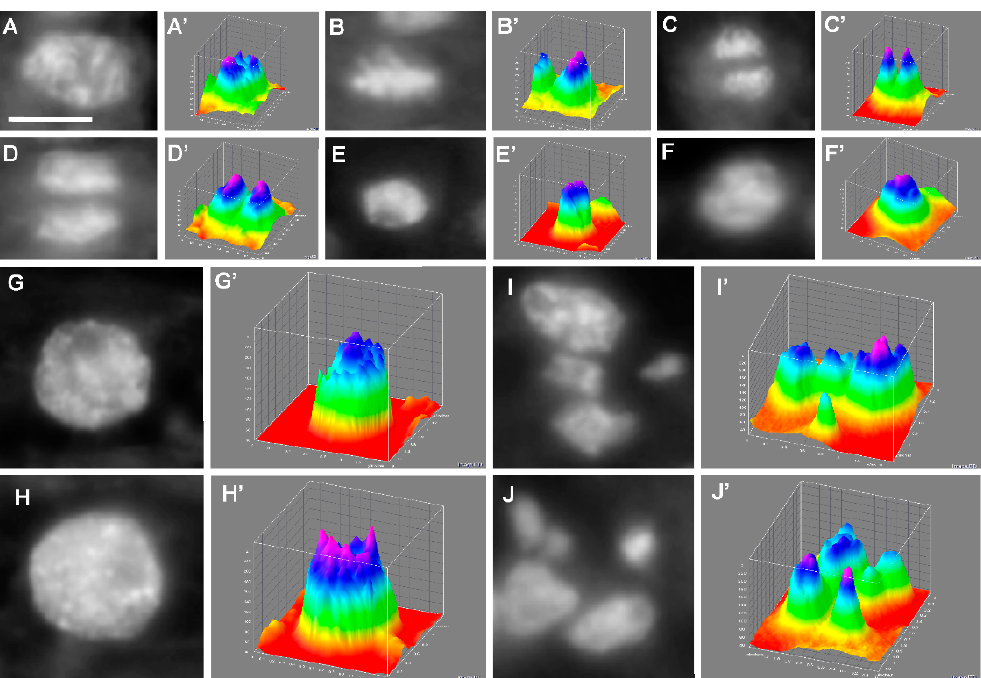
Figure 8. Micrographs ( A – J ) and their digital transformations ( A’ – J’ ), of nuclei from Zea mays axes basic zone cells fixed in Carnoy’s and stained with DAPI showing: prophase ( A , A’ ), metaphase ( B , B’ ), anaphase ( C , C’ ) and telophase ( D , D’ ), nucleus during under the G1 ( E , E’ ) and under the G2 ( F , F’ ) phases and nuclei in endocycle, i.e., endo S with 6C ( G , G’ ) and with 8C DNA ( H , H’ ) as well as nuclei fragmentation ( I , I’ ), ( J , J’ ). Scale bar is 10 μ m ( A ). The photos and digital transformations represent cells from NT seeds germinated at optimal temperature (Control): ( A , A’ ), ( B , B’ ), ( C , C’ ), ( D , D’ ) and ( F , F’ ); from hydroconditioned H seeds germinated at optimal temperature (Control): ( E , E’ ); from HMel 50 seeds after regeneration phase (R): ( G , G’ ) and ( H , H’ ); from hydroconditioned H seeds after regeneration phase (R): ( I , I’ ) and ( J , J’ ).